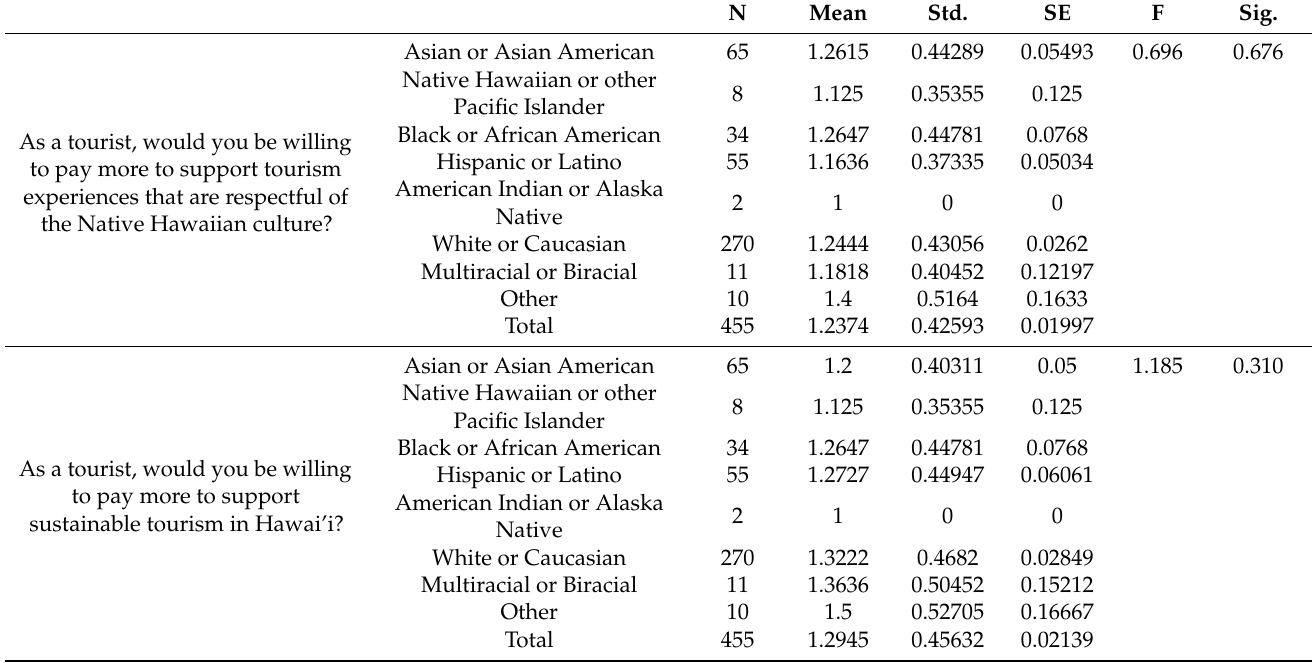
Table 10. Participants’ willingness to pay, by